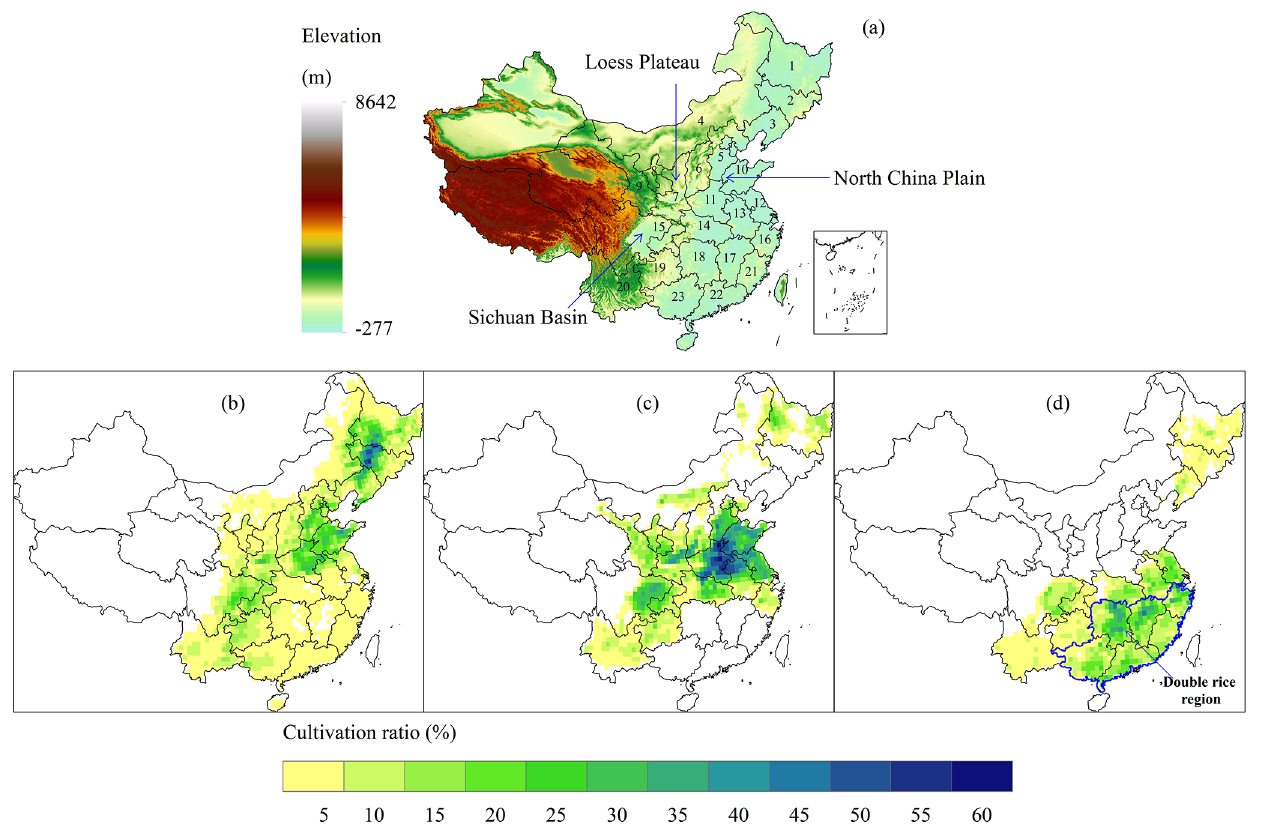
Figure 1. Terrain (a) and cultivation fractions of maize (b) , wheat (c) and rice (d) in the study area. Province codes: 1: Heilongjiang; 2: Jilin; 3: Liaoning: 4: Inner Mongolia; 5: Hebei and Beijing and Tianjin; 6: Shanxi; 7: Shannxi; 8: Ningxia; 9: Gansu; 10: Shandong; 11: